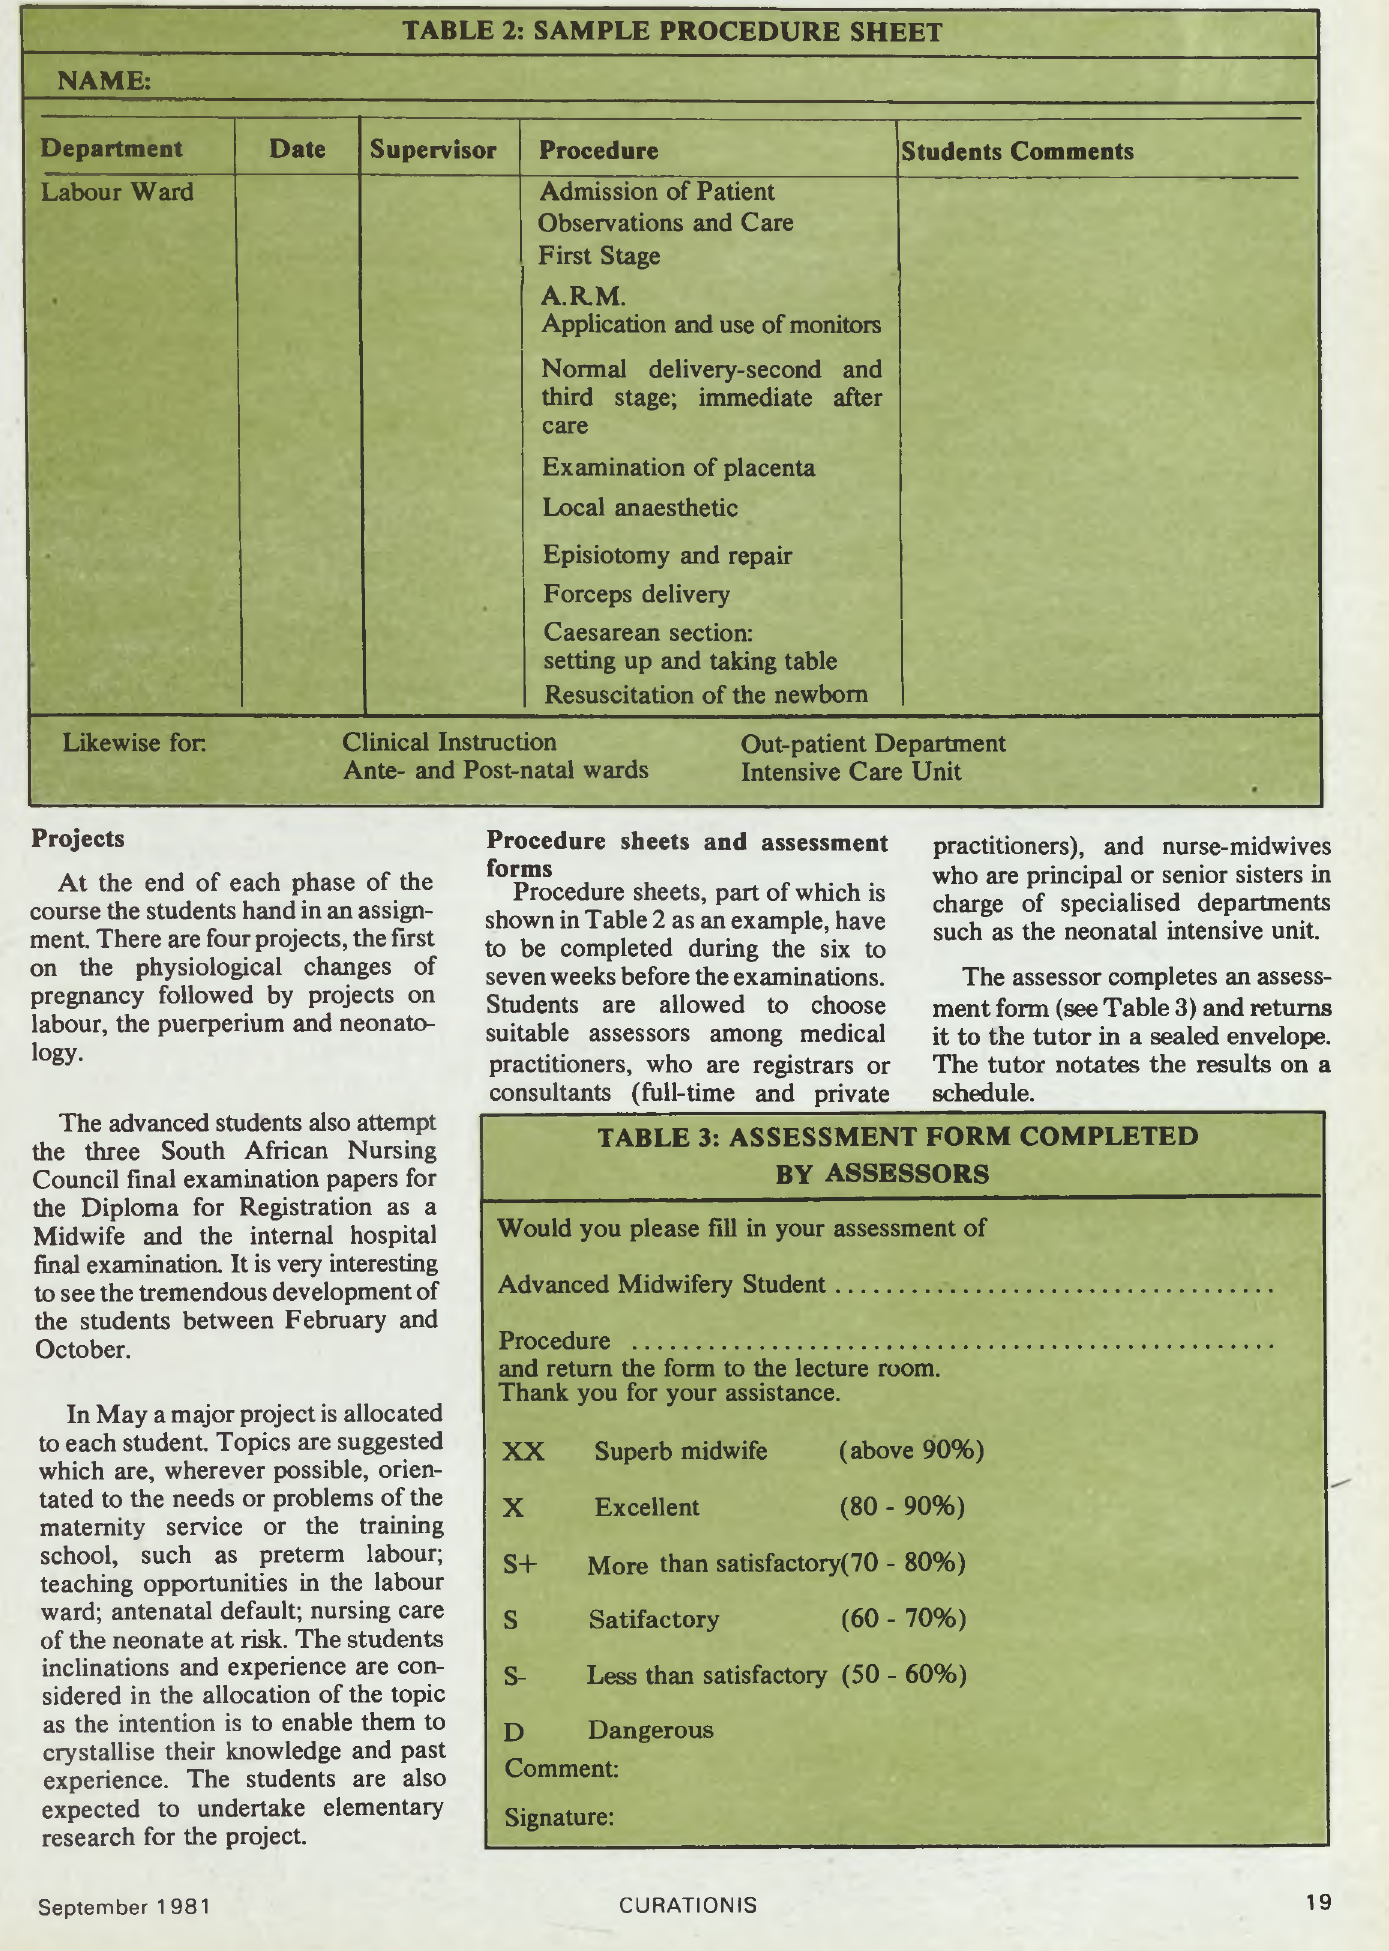
TABLE 2: SAMPLE PROCEDURE SHEET